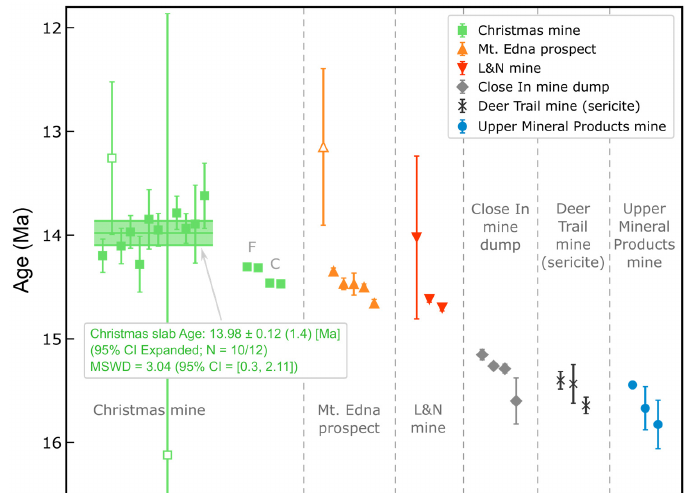
Figure 6. Summary of 40 Ar/ 39 Ar plateau and weighted mean dates for all magmatic-steam alunite samples, as well as a sample of sericite from the Deer Trail mine. The weighted mean of 10 aliquots of the banded slab from the Christmas mine is shown by the green bar with 95% confidence bounds (see Figure 5; external uncertainty in parentheses). Uncertainties are all plotted at 2 σ .